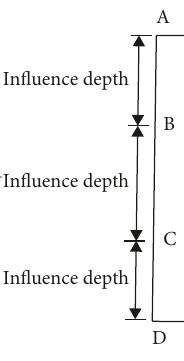
Figure 12: The definition of influence depth.